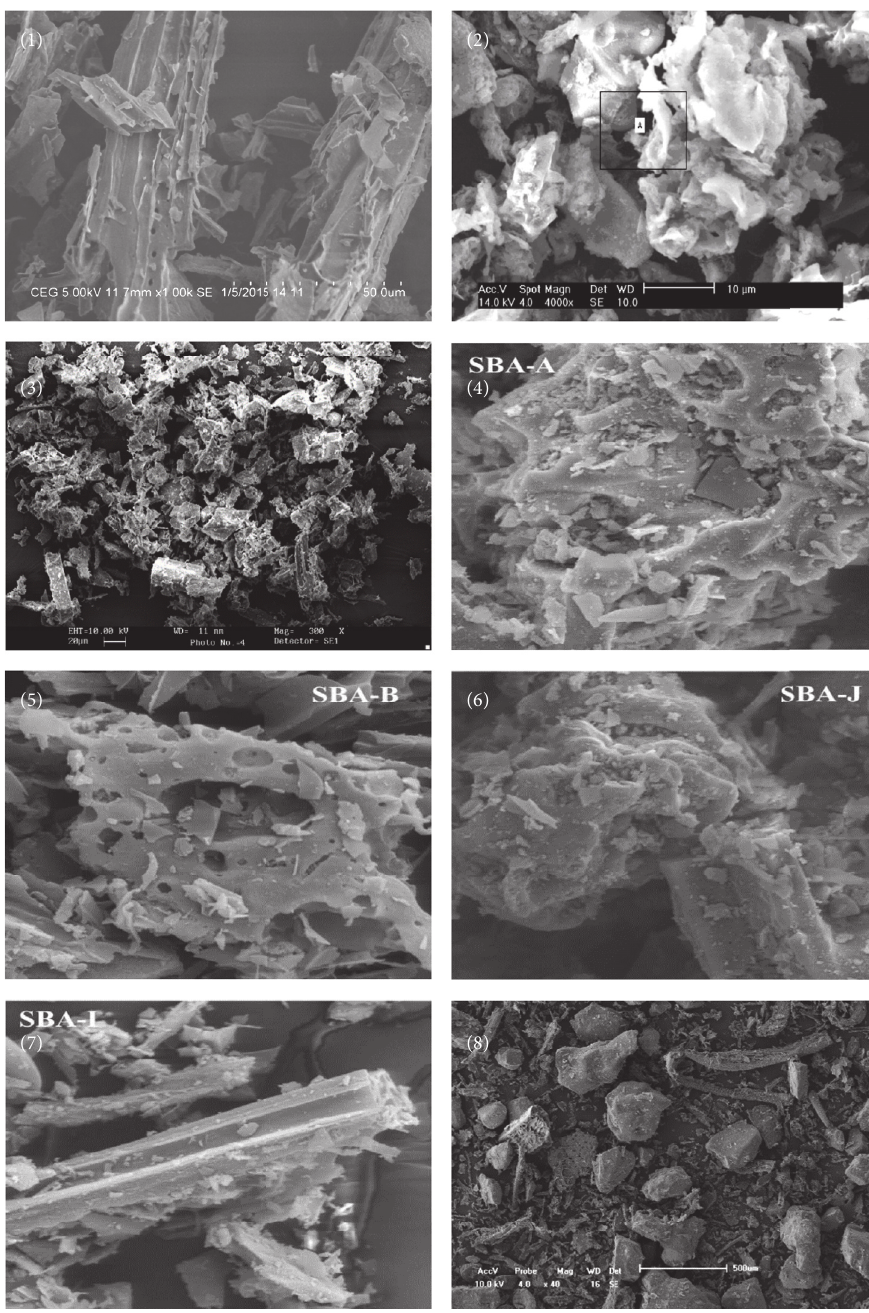
Figure 1: Microstructure of sugarcane bagasse ash (source: (1) James and Pandian [47], (2) Aigbodion et al. [60], (3) Umamaheswaran and Batra [63], (4, 5, 6, and 7) Sales and Lima [12], and (8) Faria et al.